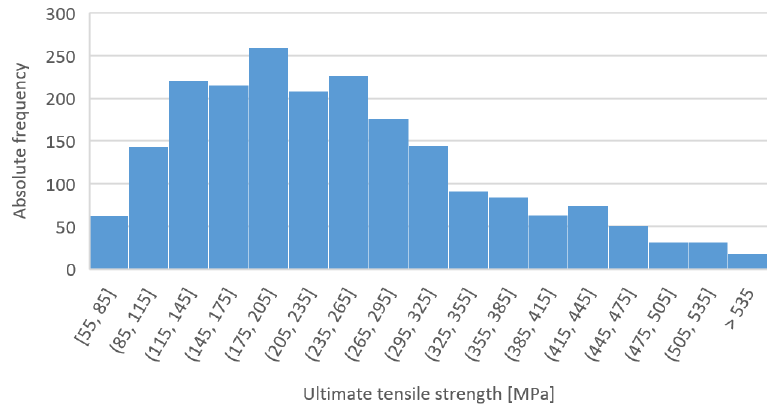
Figure 11. Ultimate tensile strength histogram of the input dataset.